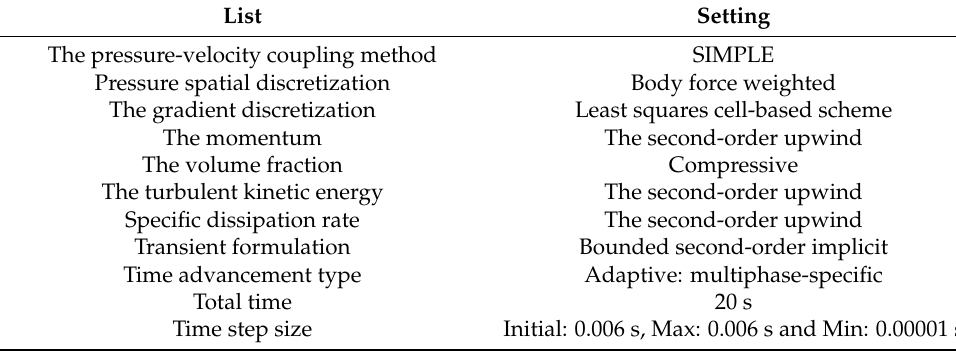
Table 3. The analysis